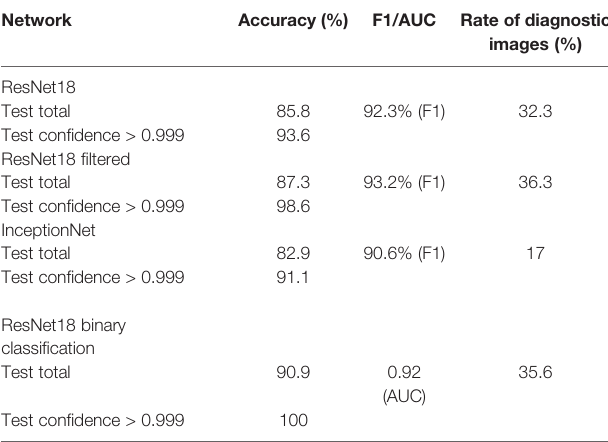
ResNet fi ltered contained manually selected data free of substantial artifacts. The ratio of images rated with an output level of 0.999 or higher and the amount of total images are indicated as diagnostic images. Images were obtained with CLE following topical ex vivo staining with fl uorescein dye. Macro-averaged F1 was calculated using the following equation: 2*(precision m *recall m )/(precision m +recall m